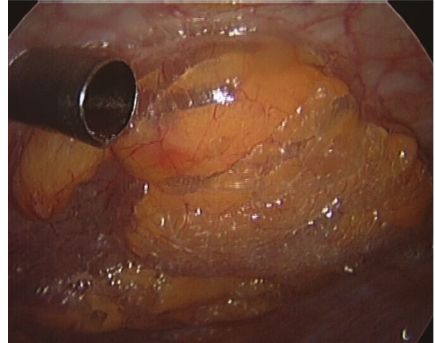
Figure 2: Bulging peritoneum during relaparoscopy without a peritoneal